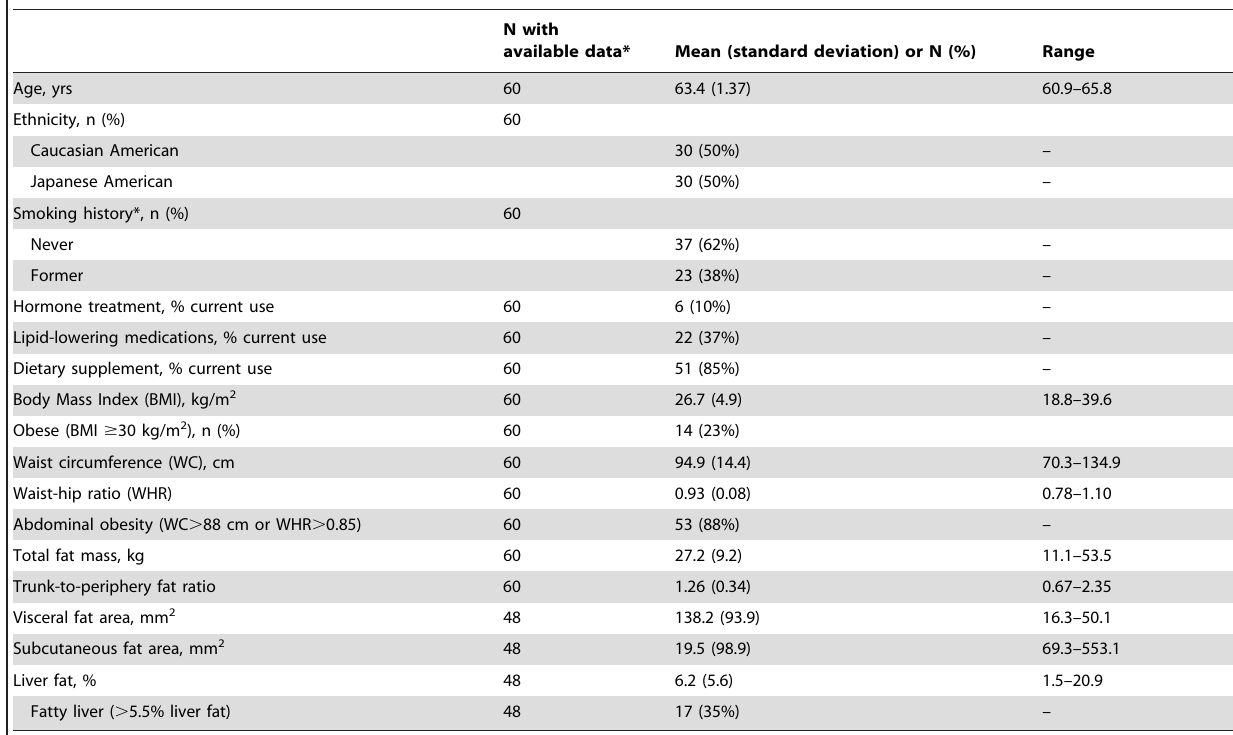
Table 1. Characteristics of participating